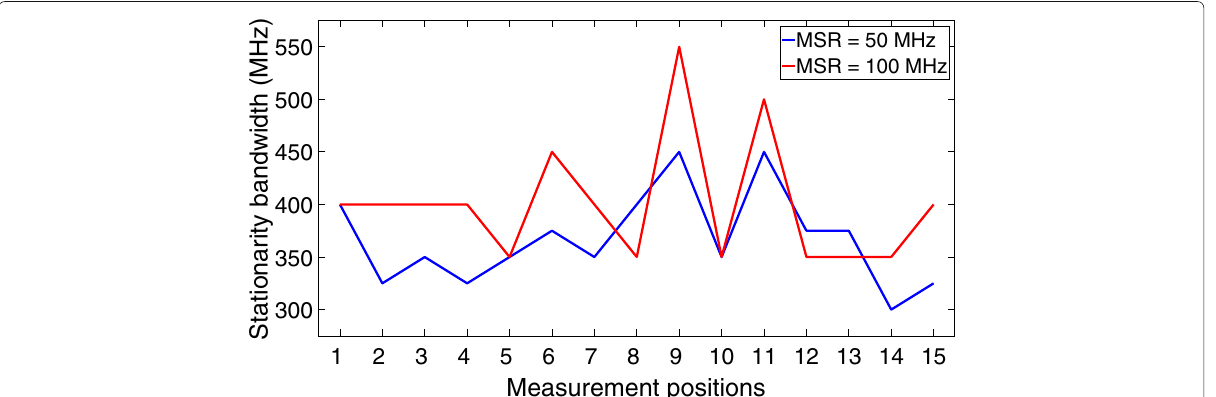
Fig. 14 Analysis of the stationarity bandwidth of the measurement data for different values of the MSR